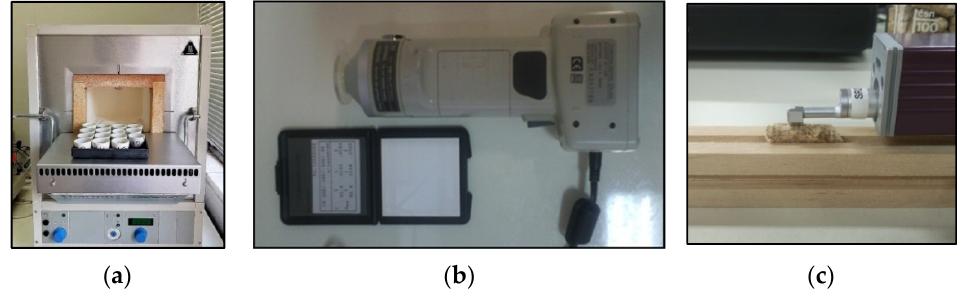
Figure 2. ( a ) Incineration kiln for ash content measurements, ( b ) Colourimeter device, ( c ) Pro- filometer (surface-roughness measurement device). (surface-roughness measurement